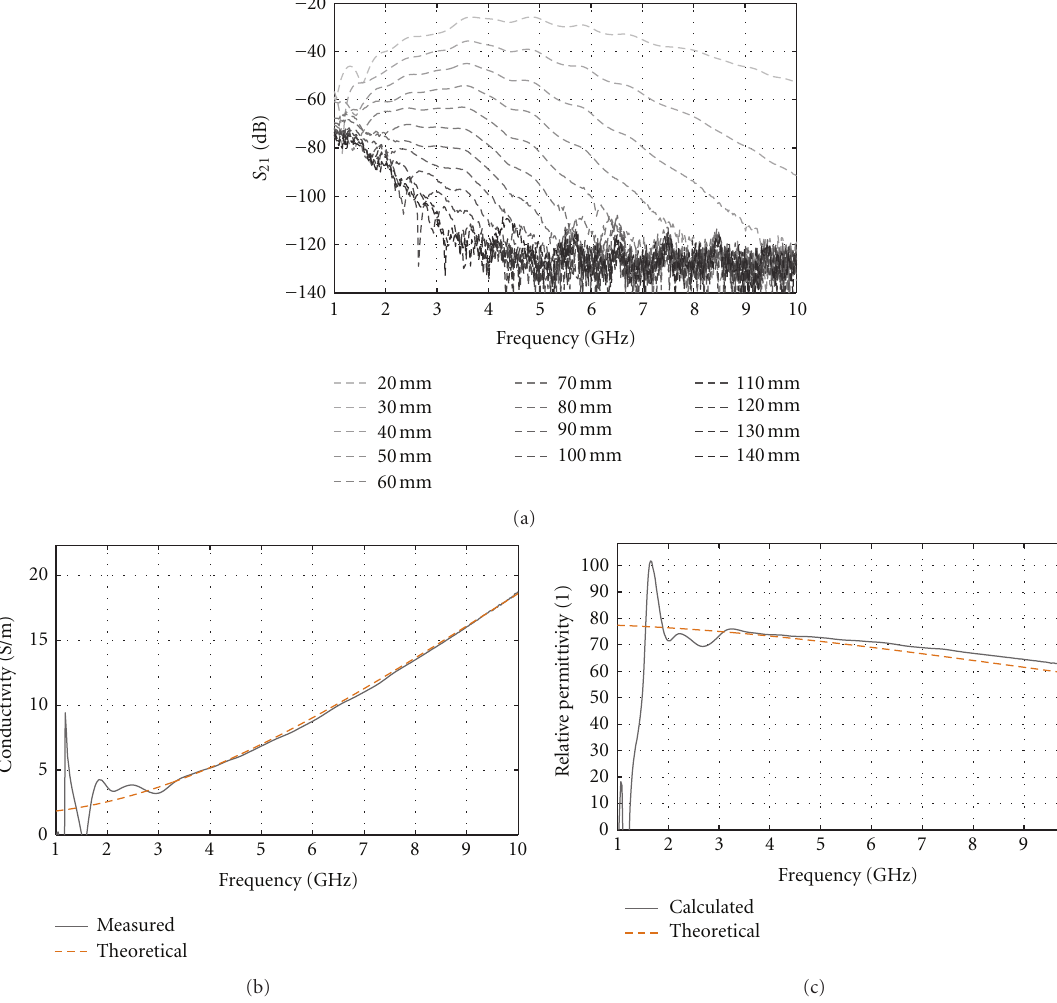
Figure 11: Measurement (a) taken with di ff erent separation distances of the sensors and the tank containing only a 1% immersion liquid. Conductivity (b) and relative permittivity (c) calculated using (2) and (3) and compared with theoretical values based on